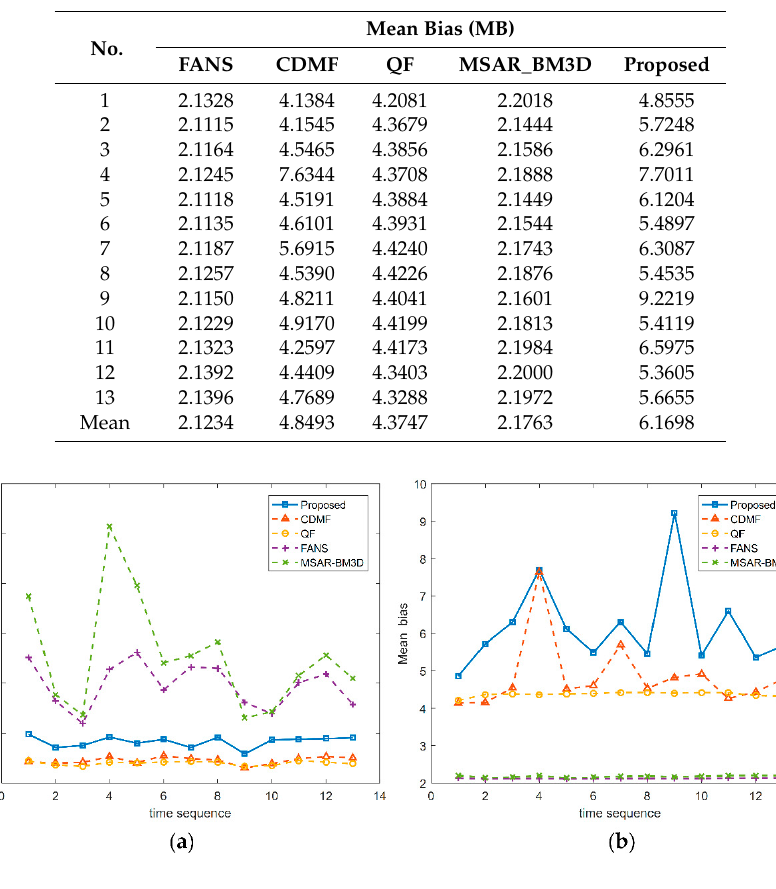
Figure 10. Change trends of the indices for Dataset 1: ( a ) ENL; ( b ) Mean bias (negative logarithm). Remote Sens. 2018 , 10 , x FOR PEER REVIEW